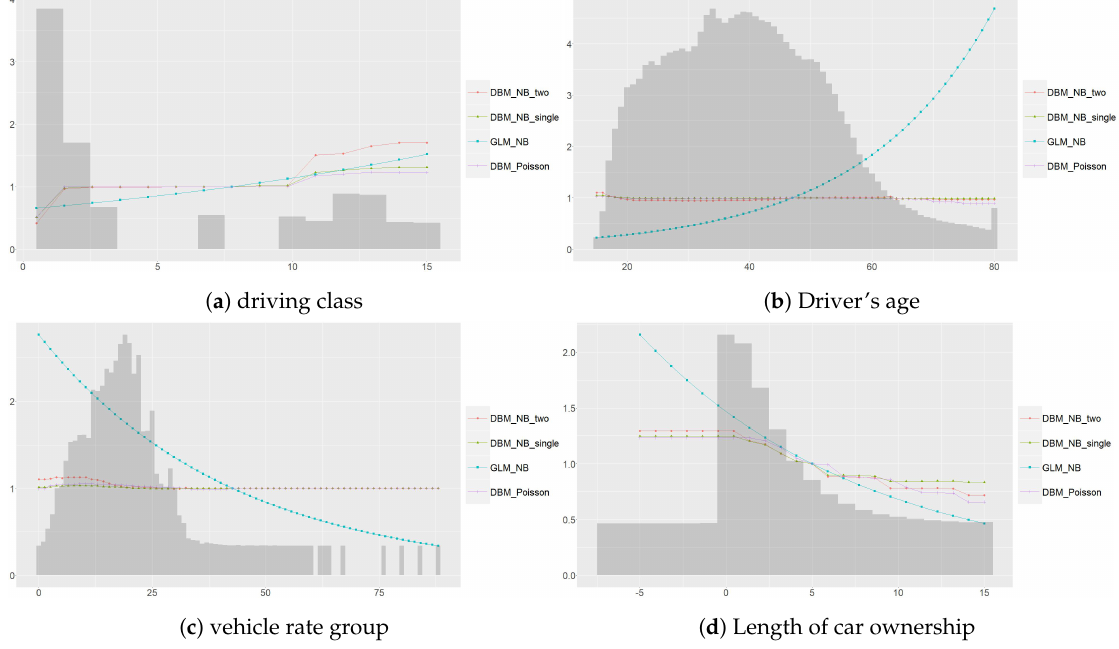
Figure 3. Normalized marginal plots for modeling